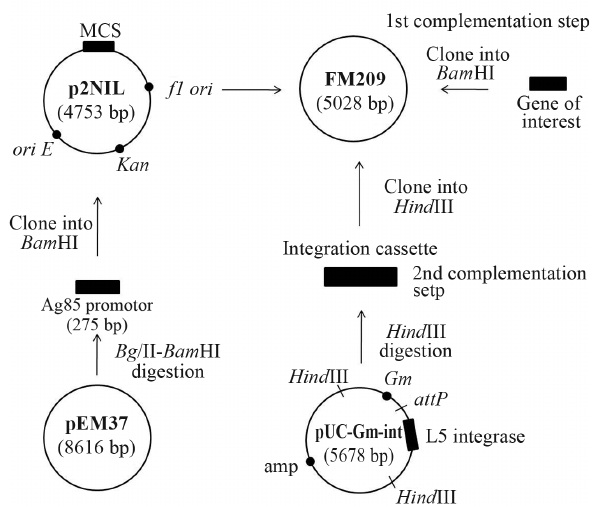
Figure 1 - Construction of pFM209 and the two-step strategy for comple-